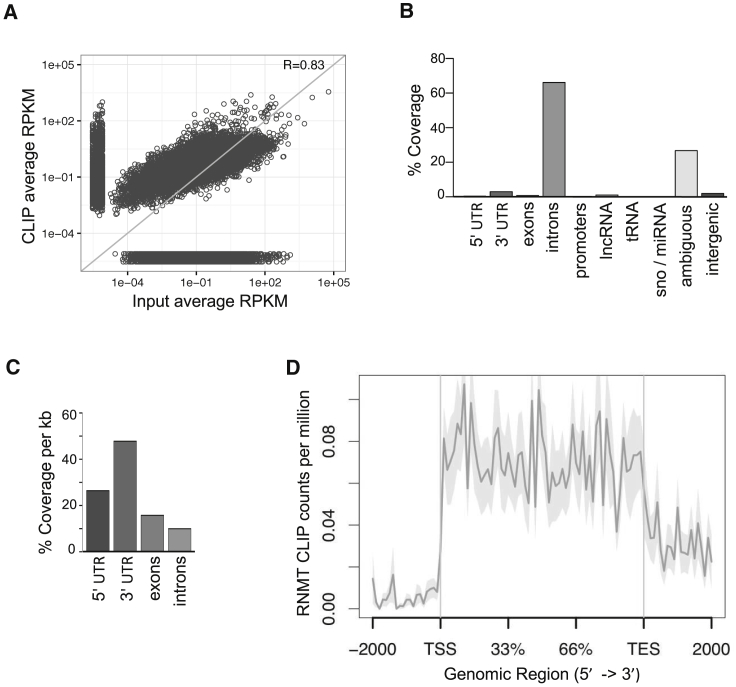
RNMT-RAM Binds throughout mRNA(A) Scatterplot of RNMT CLIP reads and inputs expressed as reads per kilobase per million mapped reads (RPKM) for each annotated gene locus.(B) Percentage of genome coverage for CLIP reads calculated over annotated regions of the hg38 genome assembly. Reads aligning to unannotated genomic regions were assigned as intergenic. Overlapping annotation was assigned as ambiguous.(C) Genome coverage calculated per kilobase of annotated mRNA features. Ambiguous is excluded.(D) Average profile from coverage splines of HA-RNMT CLIP reads over 684 RNMT-enriched target gene bodies. Shaded area represents SEM for each bin.